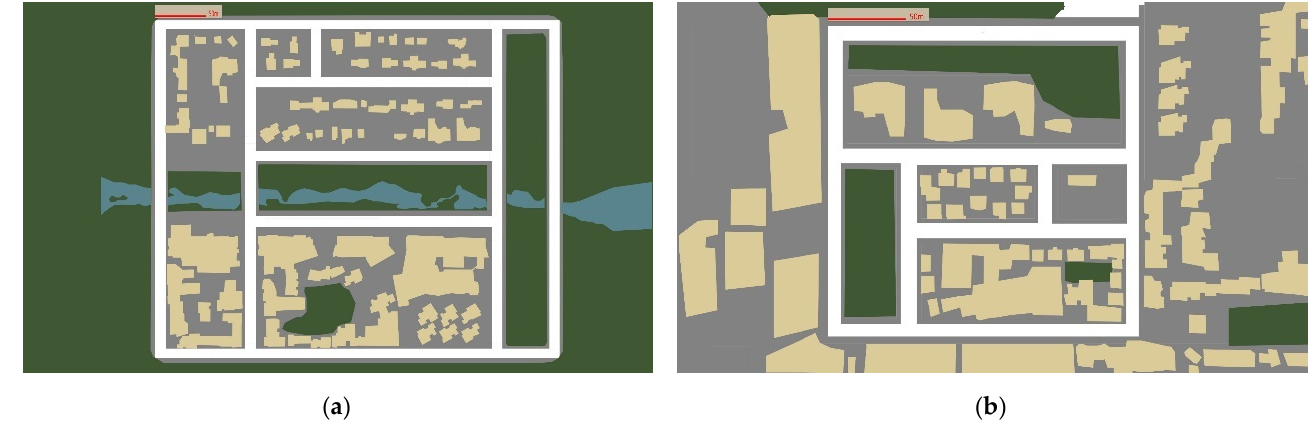
Figure 4. Aerial viewpoints of ( a ) Town 1 and ( b ) Town 2.